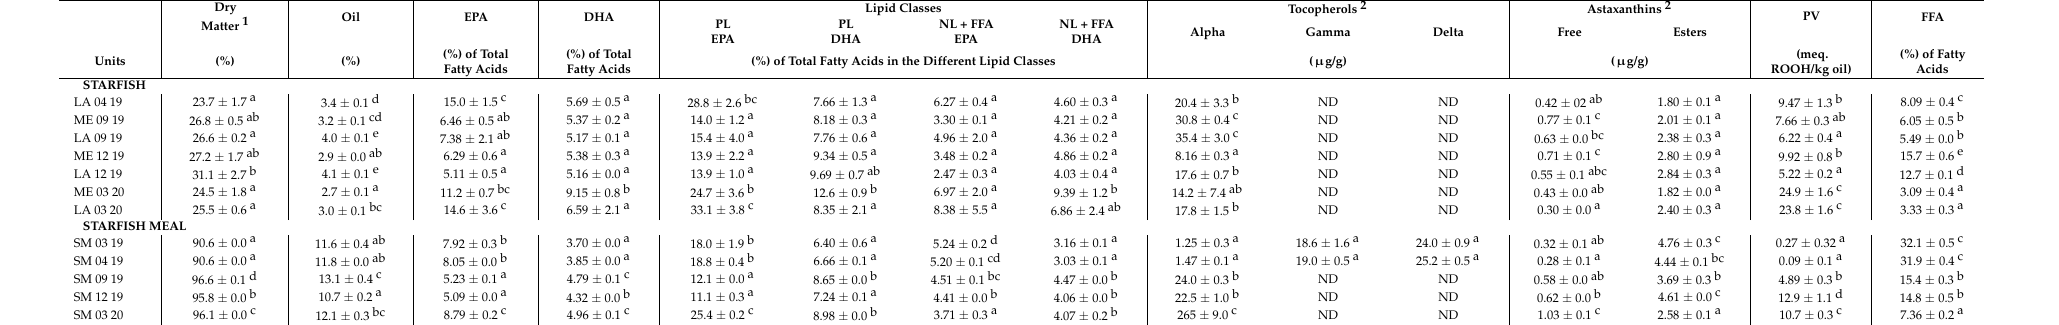
Table 2. Characterization of starfish and starfish meal at different sampling times in 2019–2020 (average ± STD, n = 3 starfish and n = 2 starfish